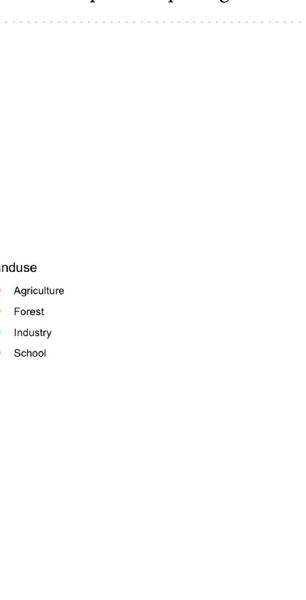
Figure 5. Heatmap of the relative abundance of the different OTUs exhibiting significantly ( p adj < 0.05 ) high indicator values (Inv > 0.5) and high abundances (> 1% relative abundance) compared with mean relative abundance in each land-use soil. Indicator analysis was performed using the indicspecies R package.